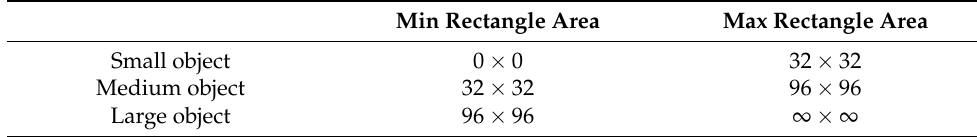
Table 3. The size criterion for grouping small, medium, and large